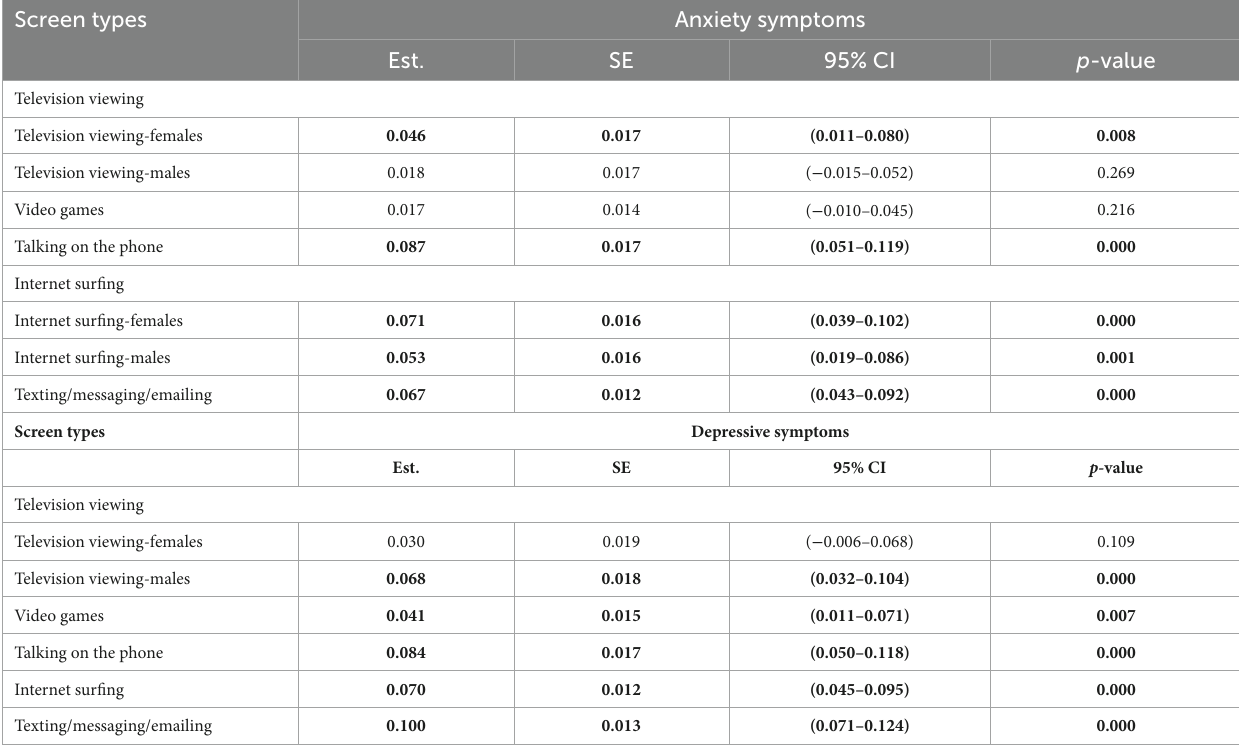
TABLE 4 Association between one-year change in screen time and changes in anxiety and depressive symptoms among adolescents in the COMPASS study (2017–18 to 2018–19). Screen